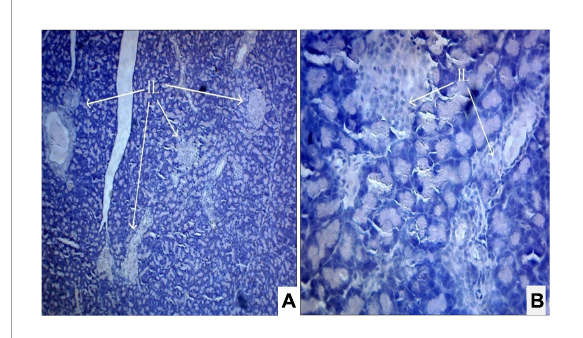
FIGURE3 (A,B) Photomicrograph of pancreas from glibenclamide (6 mg/kg)-treated diabetic rat showing partial restoration of normal cellular population and size of islet cells. The acinar cells are seen to be normal. (A) H & E 10X; (B) H & E 40X. IL, islets of Langerhans cells.